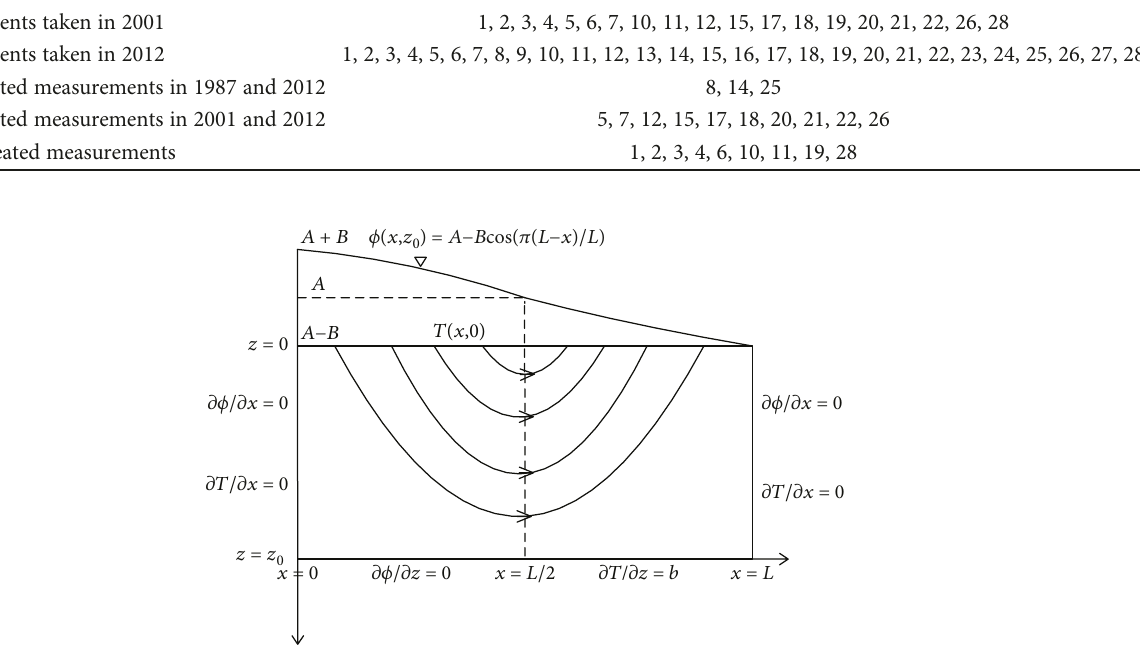
Figure 4: 2D diagram showing the conceptual model and boundary conditions for the subsurface water-heat fl ow investigation (revised from the conceptual model noted by Domenico and Palciauskas